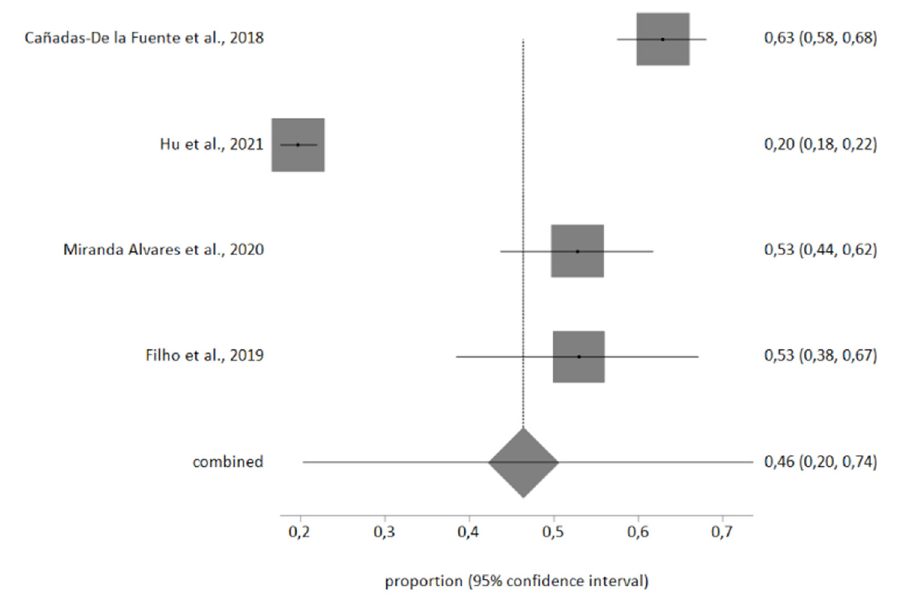
Figure 4. Low PA forest plot.